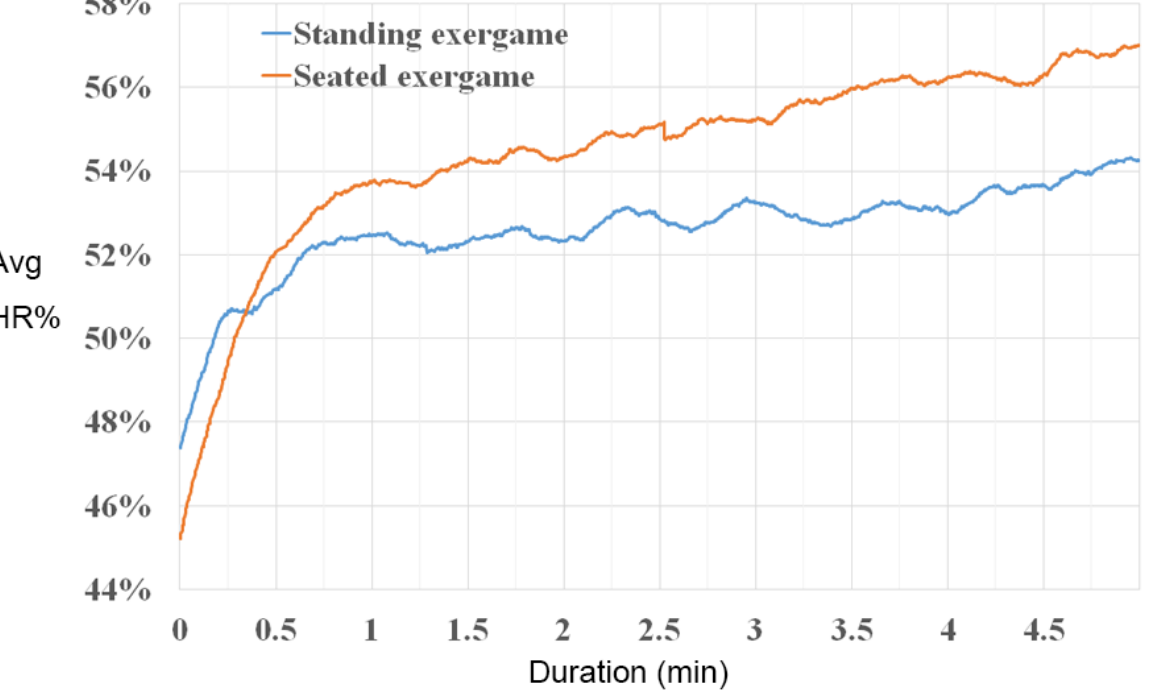
Figure 5. Mean AvgHR% during gameplay for both versions of the exergame; the interaction between two lines occurs at 0.38 minutes. At 2.64